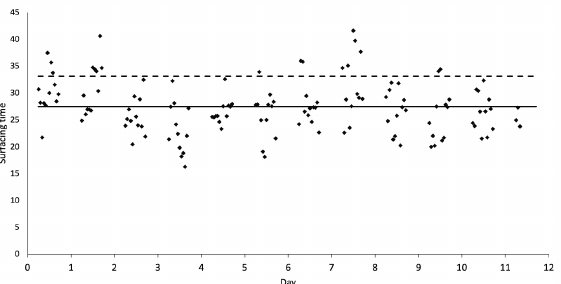
Figure 6: Proportion of time spent at the surface (0-2m) during 12 days and between 6:00 and 18:00 for one whale in East Greenland (#3965) calculated with Method 2. The line shows the mean values from Method 2 (mean=27.4, SD=4.8) and the stippled line indicate mean values from Method 1 (mean=33.1).